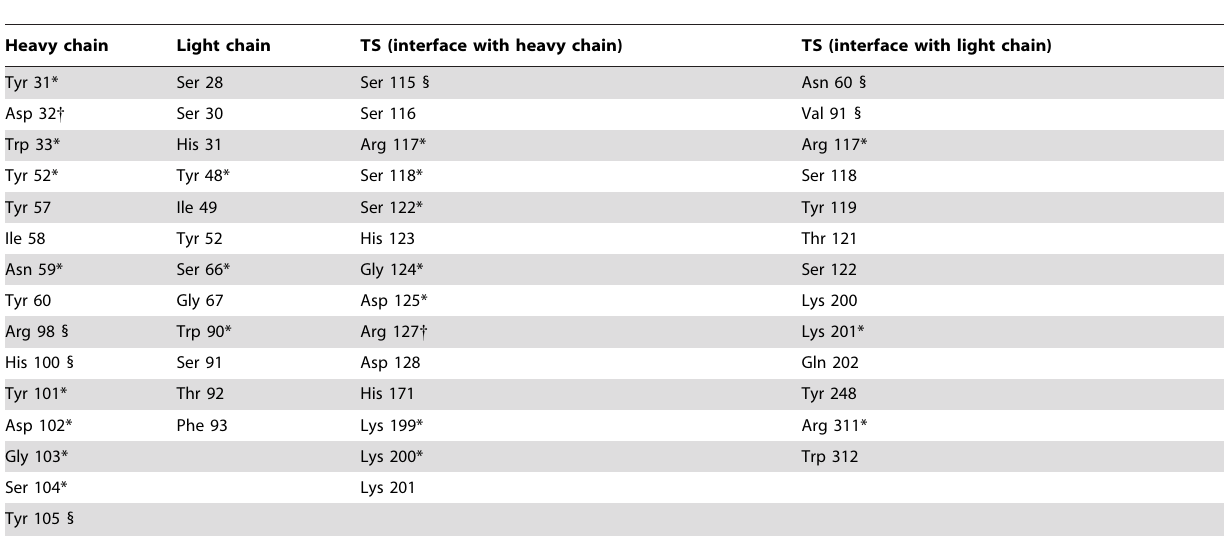
Table 2. Residues that display a significant change in solvent-accessible surface, comparing the separate and complexed structures of TS and mAb 13G9.